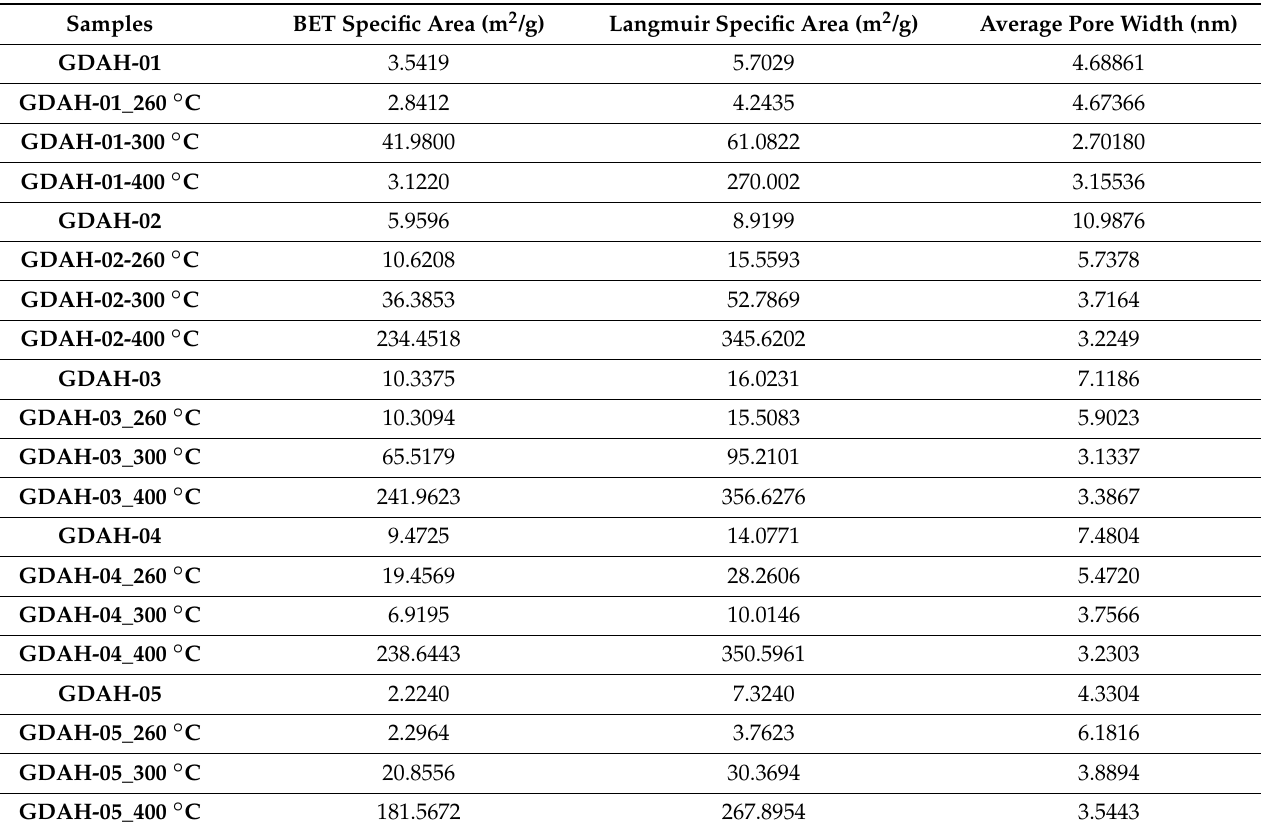
Table 1. Specific surface area and pore width measurements for the initial samples and after thermal treatment at 260 ◦ C, 300 ◦ C and 400 ◦ C for 2